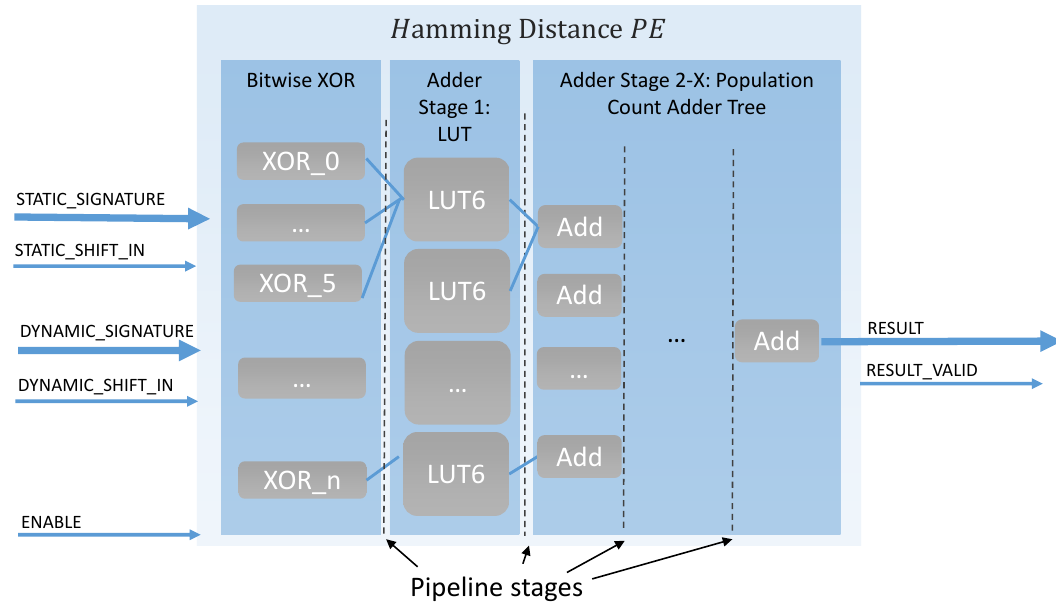
Figure 3. Hamming distance